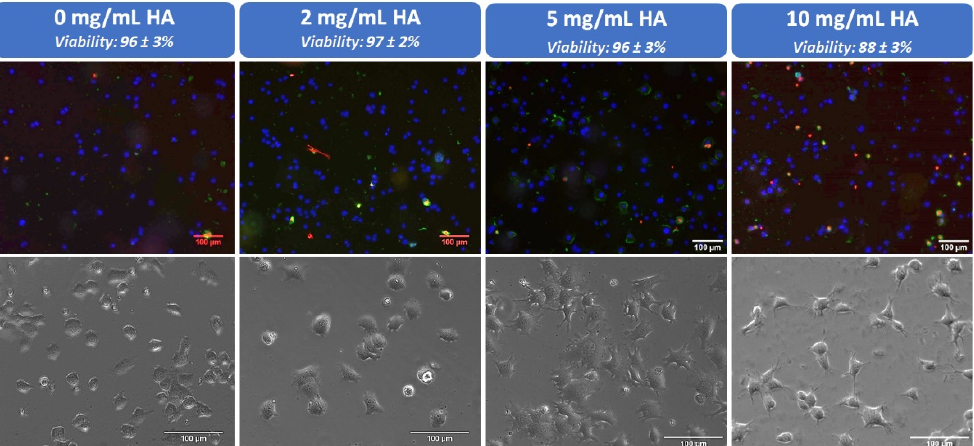
Figure 6. Apoptotic/necrotic/healthy cells detection kit was used to determine the cell viability of NIH 3T3 fibroblasts after 4 h in contact with different hydrogel coatings containing 0, 2, 5 and 10 4 h in contact with different hydrogel coatings containing 0, 2, 5 and 10 mg/mL HA. Live cells are stained in blue and death mg/mL HA. Live cells are stained in blue and death cells in red. Phase contrast microscopy images cells in red. Phase contrast microscopy images showing NIH 3T3 fibroblasts cell spreading on the hydrogel showing NIH 3T3 fibroblasts cell spreading on the hydrogel coatings.